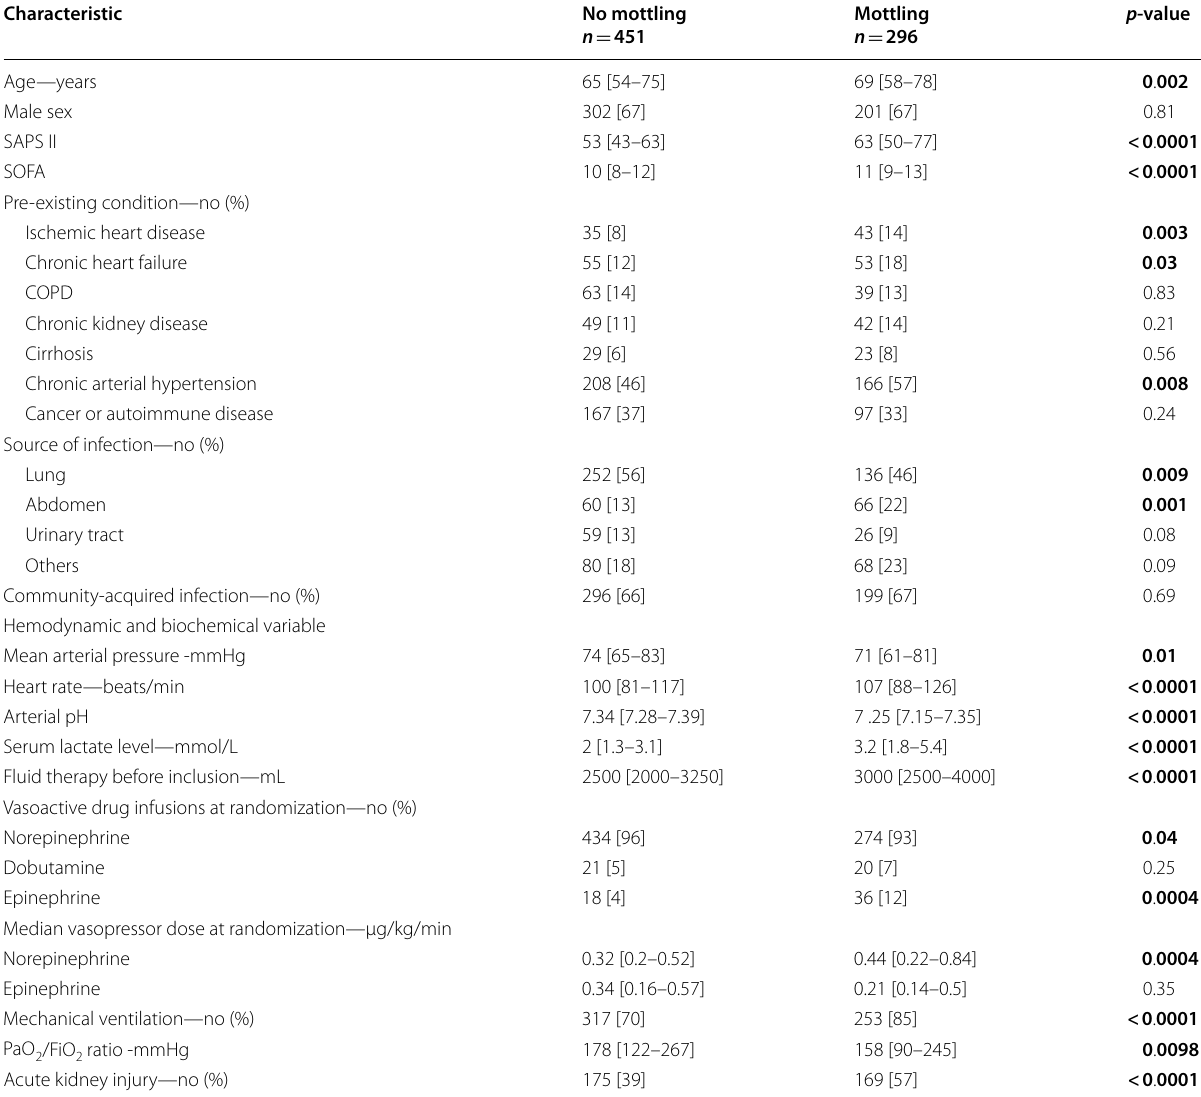
Table 1 Baseline characteristics of study patients according to the presence or absence of mottling at baseline or during the first 24